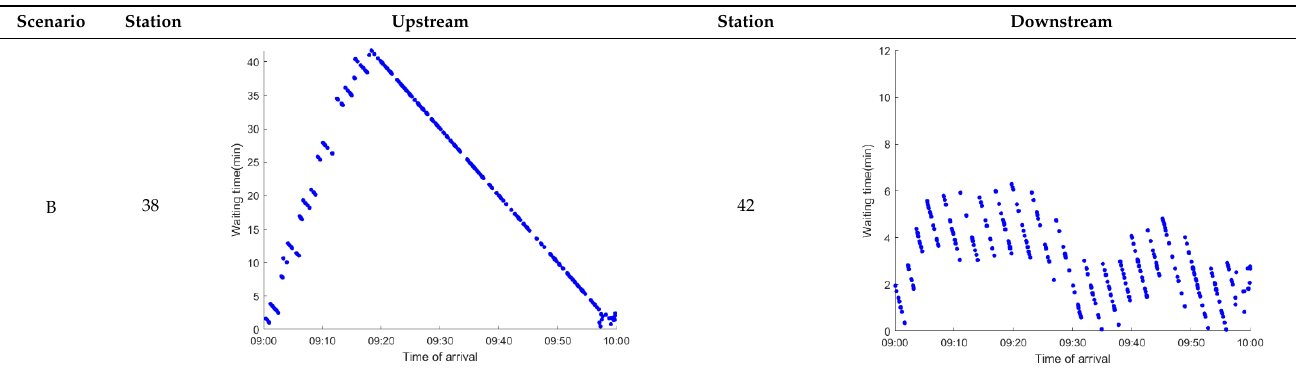
Table 12. Distribution of waiting time per bus passenger in Scenario B.